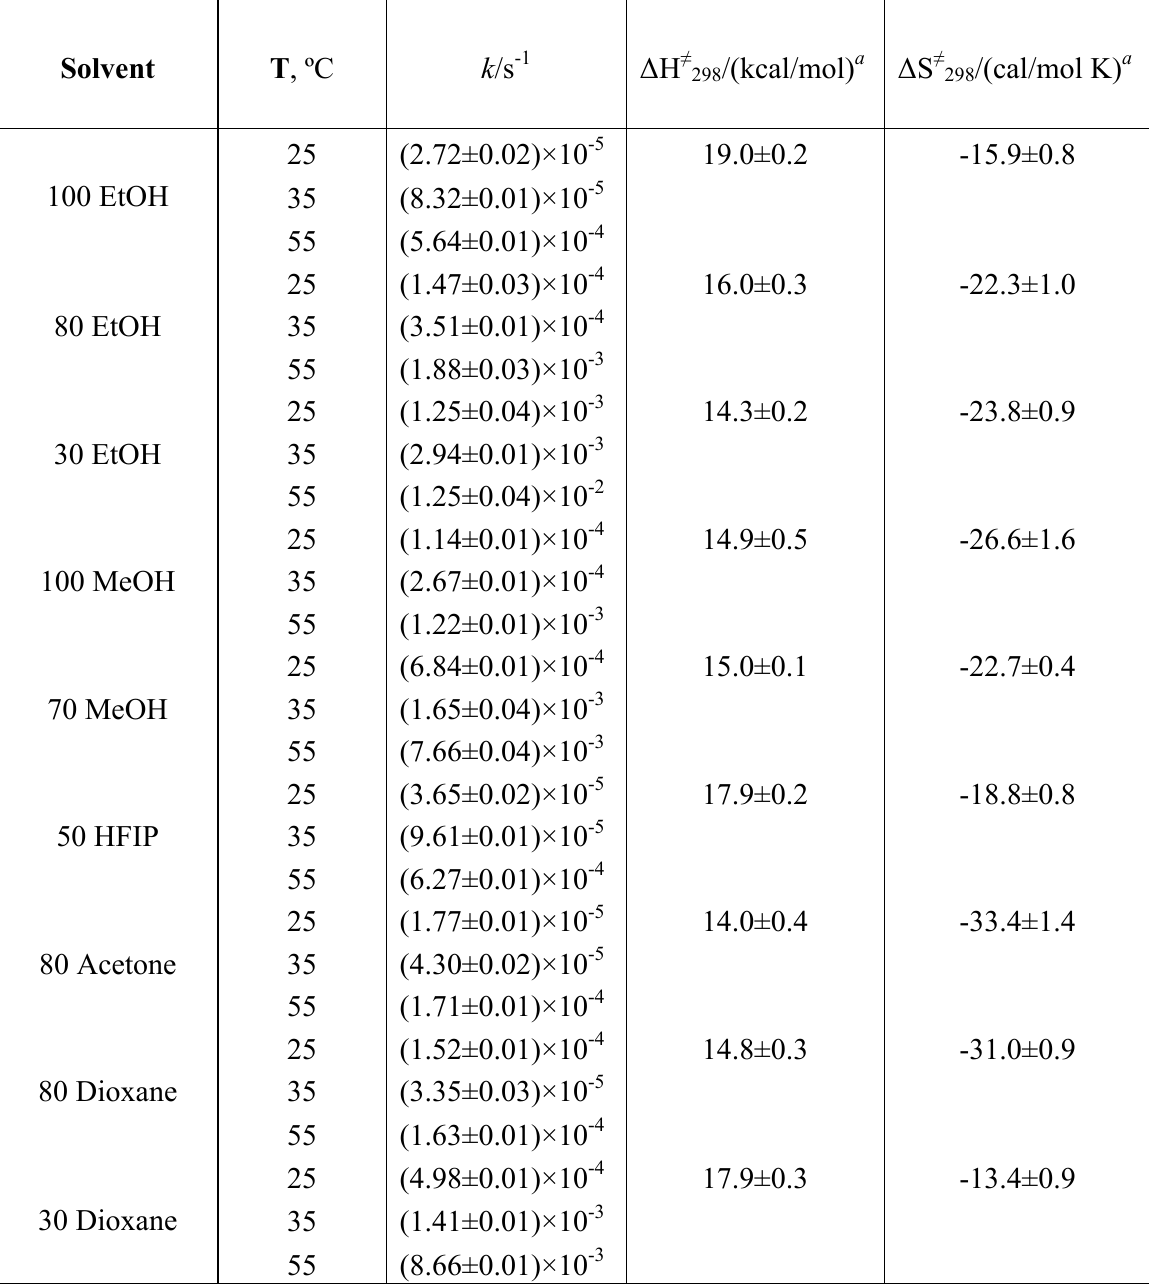
Table 5 . Specific rates ( k/s -1 ) of solvolysis for trans - β -Styrenesulfonyl Chloride at temperature other than 45.0 ºC and activation